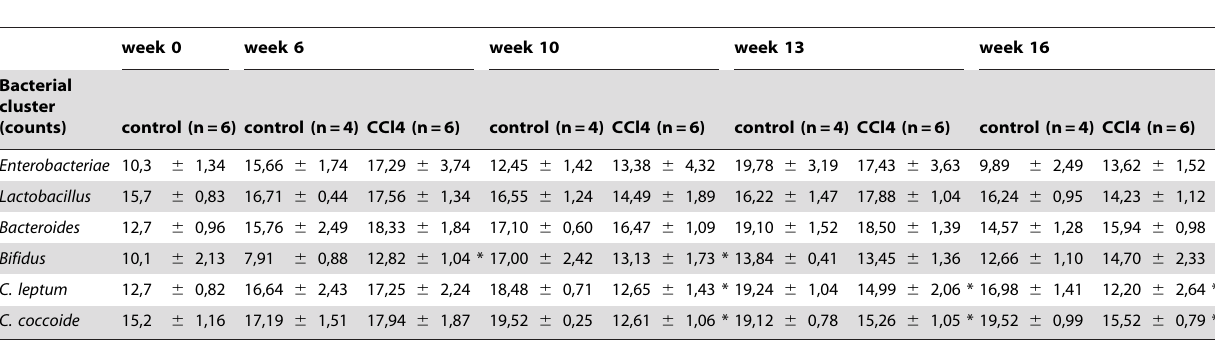
Table 2. Gut microbiota changes during the study protocol in control and CCl 4 -treated mice.